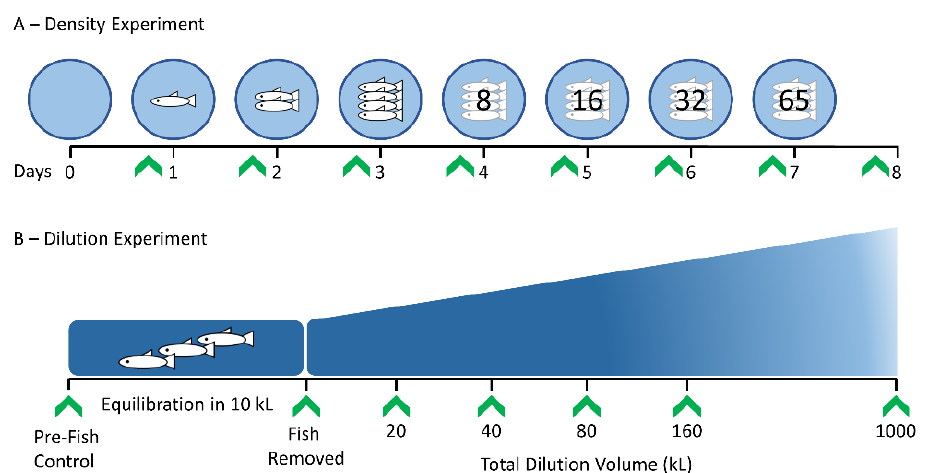
Figure 1. Schematic representations of the two experiments performed in 10 kL tanks at the Gold- stream Hatchery. ( A ) a density experiment where pre-fish negative controls were collected from each tank prior to addition of juvenile coho salmon at increasing densities of 1, 2, 4, 8, 16, 32 and 65 fish per tank at 24 h intervals; and ( B ) a dilution experiment where three coho salmon were removed from the 10 kL tank after a 9 d equilibration and samples taken at time zero (10 kL) and after cumulative flow-through volumes of 20, 40, 80, 160 and 1000 kL. Four 10 kL tanks were used in each experiment. Collection times of 2 L water samples for eDNA analysis are indicated by green arrows.